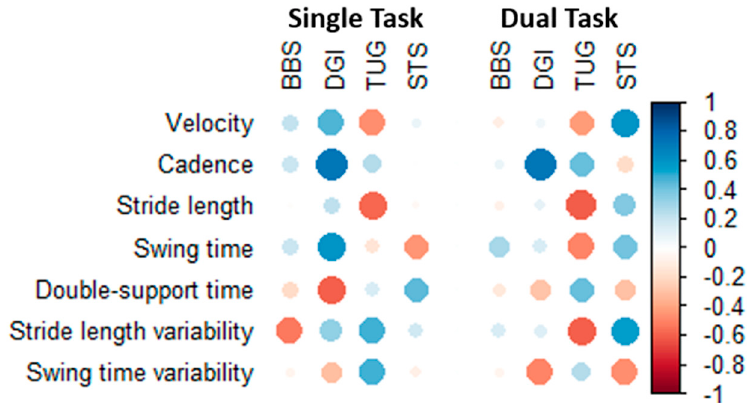
Figure 2. Correlation between GAITRite parameters and functional balance tests in patients using walkers. Blue represents positive correlations, and red color represent negative correlations. Color saturation and dot sizes represent correlation strength. Abbreviations: BBS, Bergs Balance Scale; DGI, Dynamic Gait Index; TUG, Timed Up and Go; STS, Sit To Stand test.